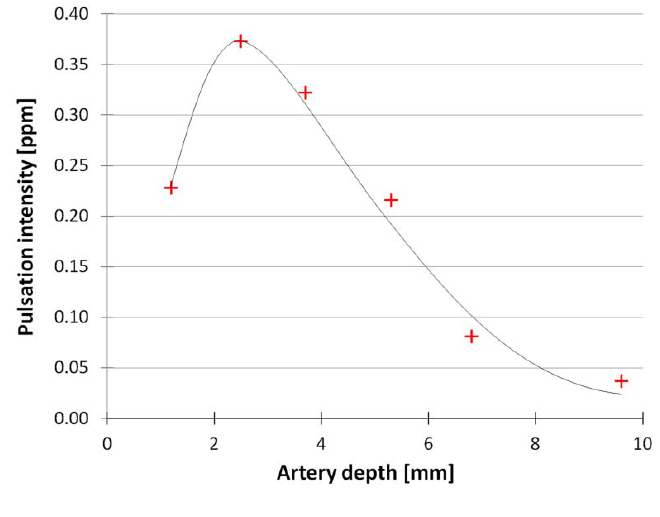
Figure 6. Simulated pulsation intensity in function of the artery depth. Successful simulation was carried out at six different artery depths, marked by red crosses. Around 2.5 mm depth the sensed pulsation intensity has a maximum